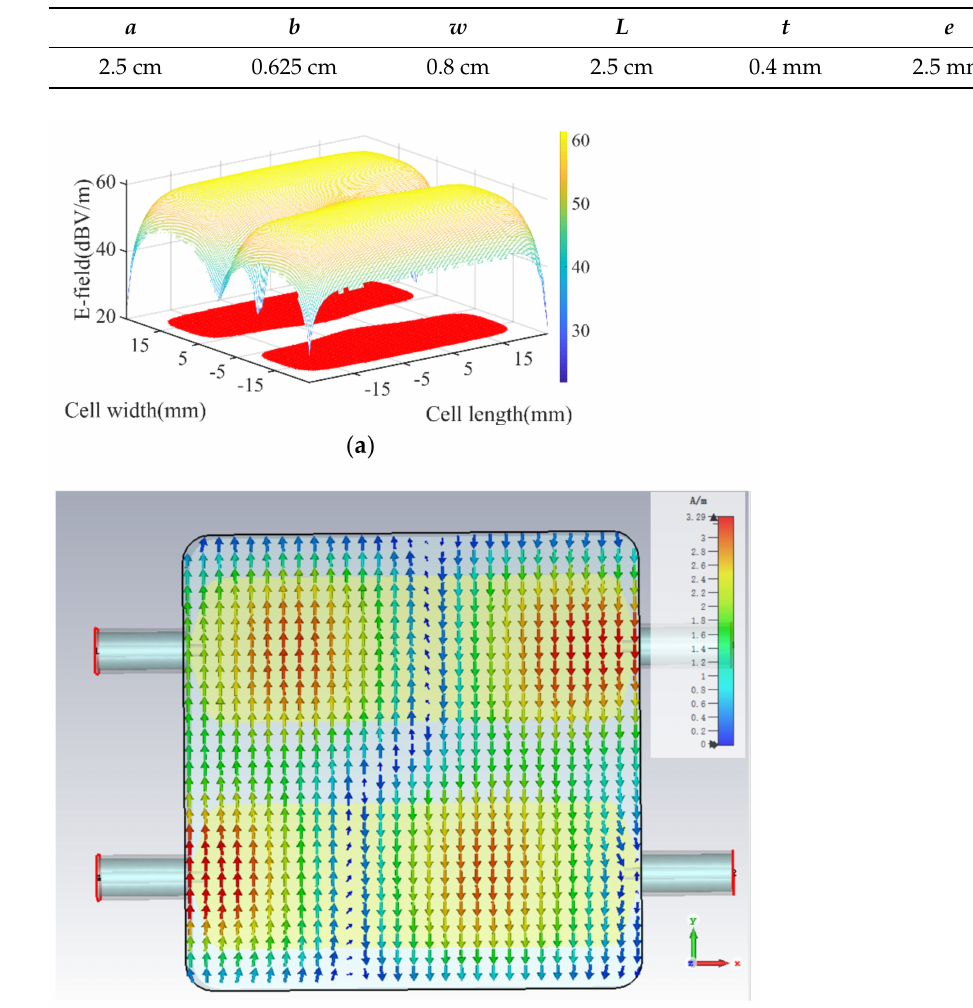
Table 3. Dimensions of scaled-down IC-Stripline cell based on image theory.